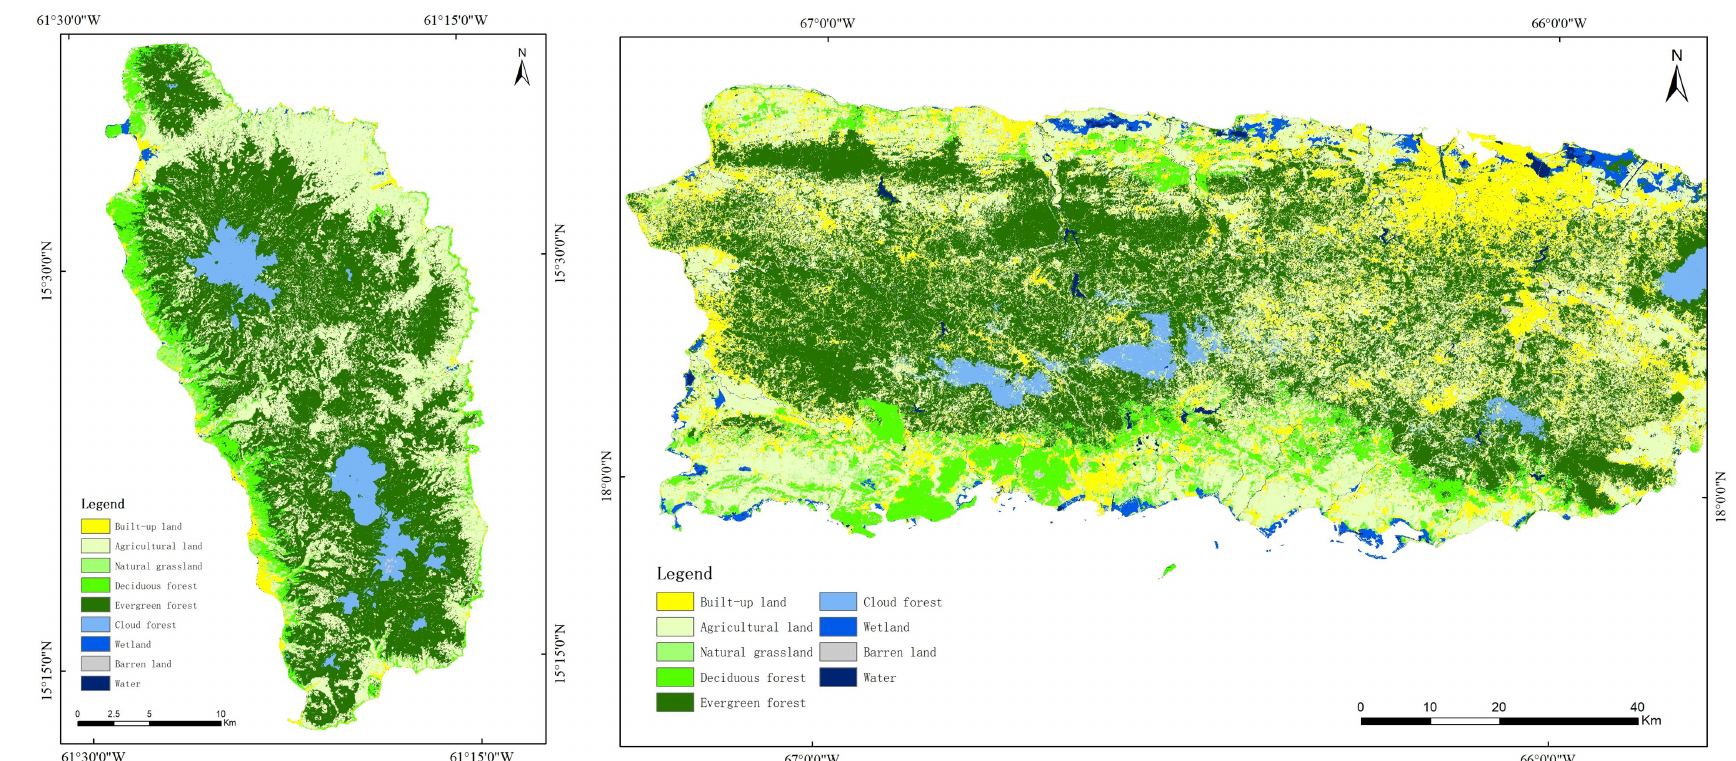
Figure 5. 2017 Land cover maps. ( a ) Dominica; ( b ) Puerto